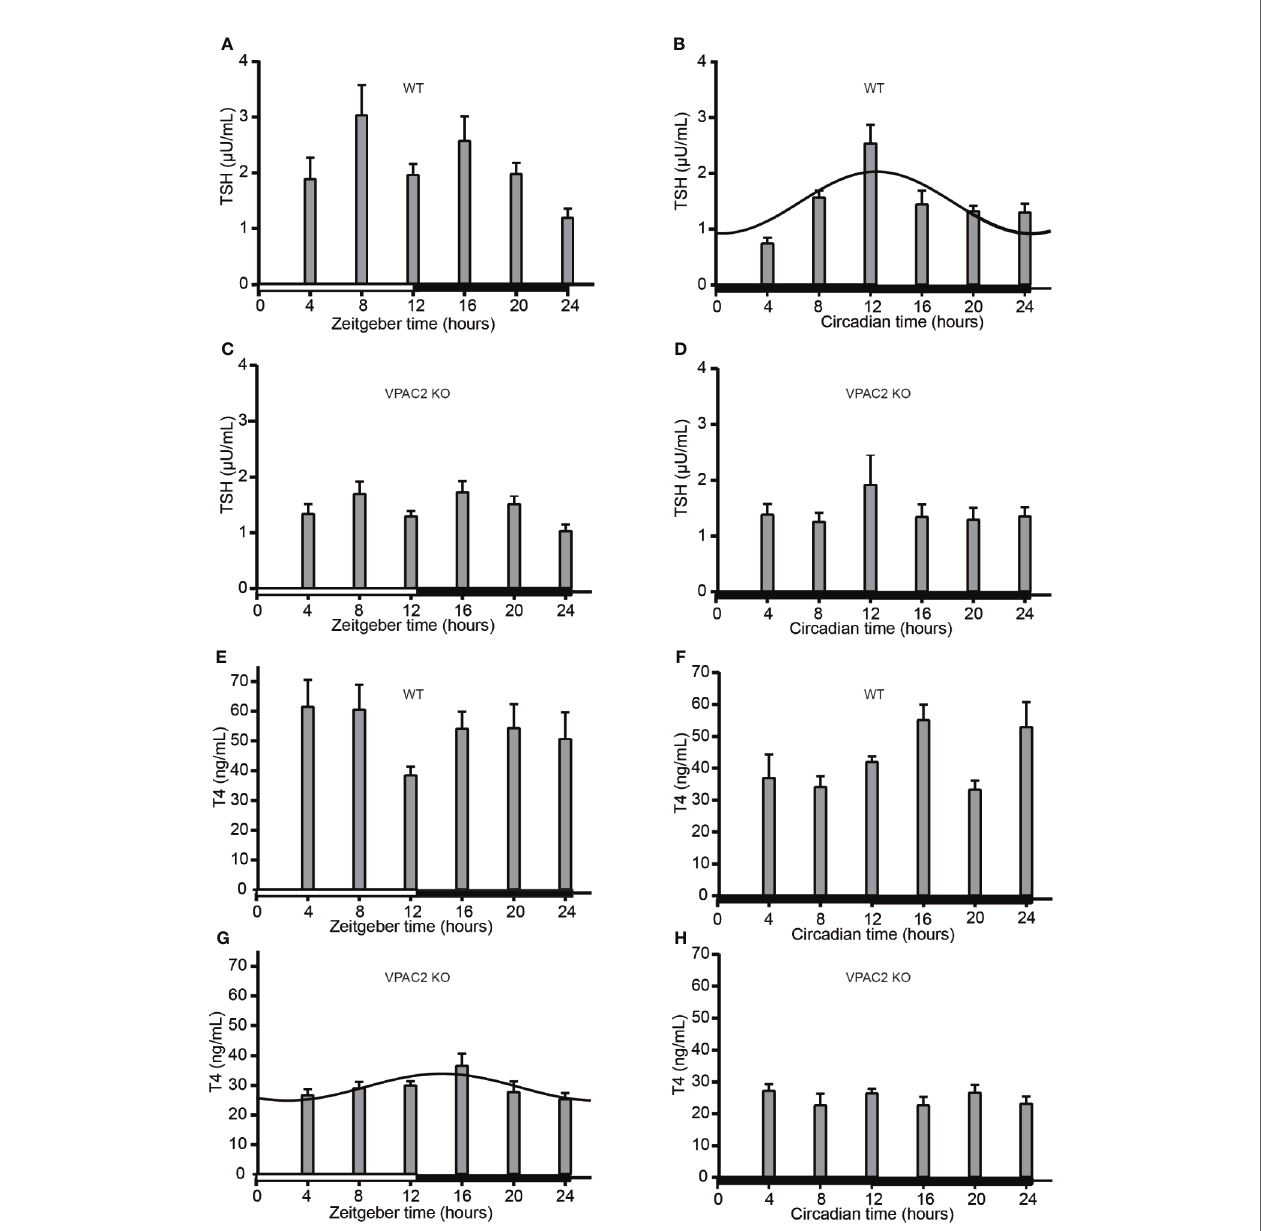
FIGURE 4 | Serum concentrations of TSH (A – D) and T4 (E – H) in wild-type (WT) (A, B, E, F) and VPAC2 receptor knockout (KO) mice (C, D, G, H) during a 12:12 h light/dark period (A, C, E, G) and constant darkness (B, D, F, H) . Commercial ELISA kits were used for the quanti fi cation of hormone concentrations in serum. TSH (A – D) in sera from WT animals (A) and T4 (G) in sera from KO mice fi tted 24 h cosinor rhythmicity. In WT animals, the TSH concentration was signi fi cantly higher at ZT/CT12 than